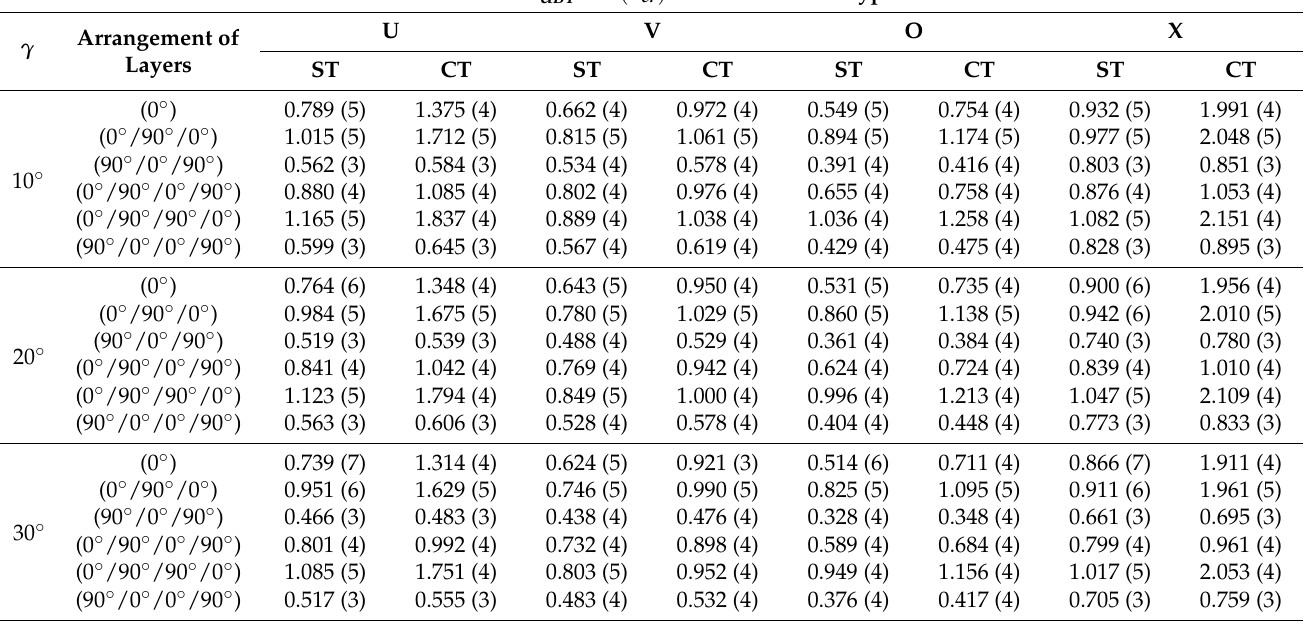
Table 3. Variations of UBT for single-layer and laminated cones with CNT-shaped layers for Par- and Cos-Hyp-SS functions (within CT versus γ ).